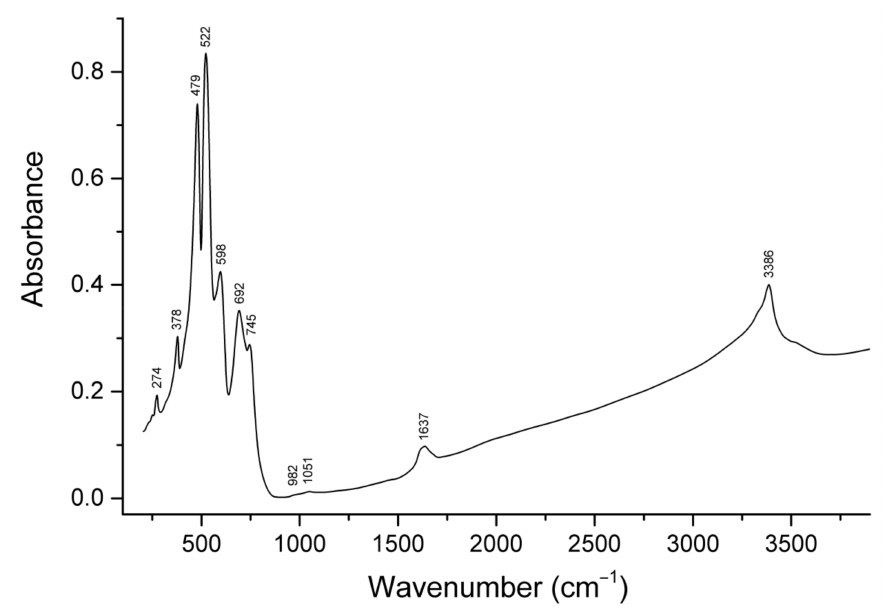
Figure 5. IR spectrum of ramsdellite from Chihuahua, Mexico, drawn using data from Potter and Rossman